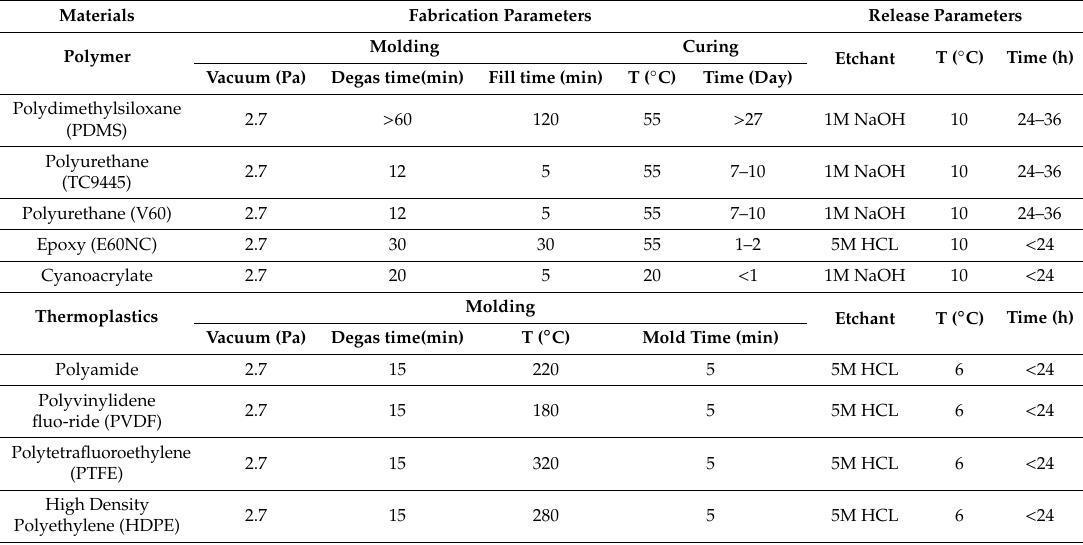
Table 1. Summary of materials and processing parameters used in fabricating